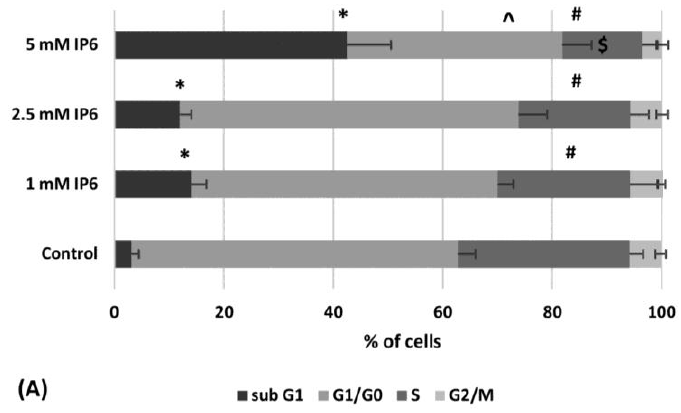
Figure 2. Figure 2 . Cont .